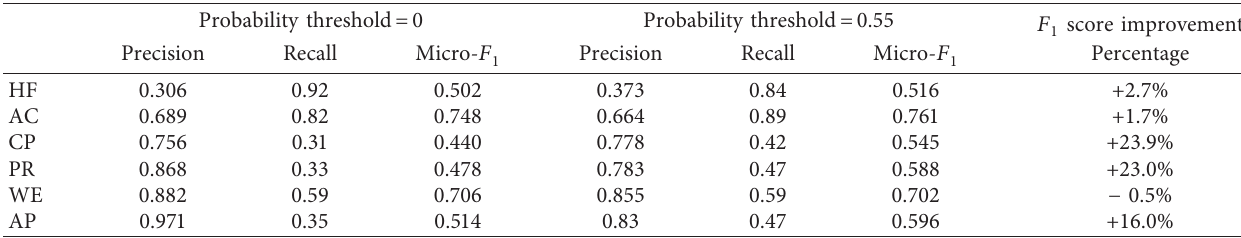
Table 9: After applying the threshold, the model’s overall performance in terms of micro- F precision and recall become more balanced.